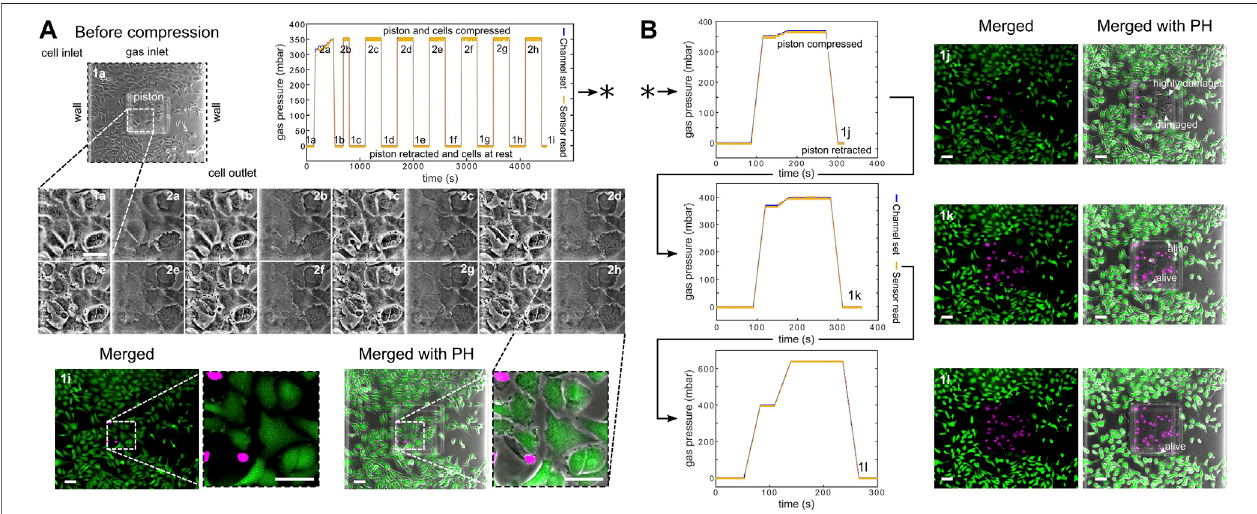
FIGURE 6 | Continuous sequence of cyclic compression pro fi les applied to a monolayer of SKOV-3 cancer cells in a continuous manner. (A) Before compression image of the cells corresponds to step “ 1a ” of the cyclic compression. In the fi rst pressure pro fi le, at step “ 2a, ” a pressure amount ladder was formed up to 354 mbar, duringwhichcellsshoweddistinctdeformation.Subsequently,cellswerechronicallycompressedfor5 minat354 mbarandthenrestedfor5 minat0 mbar(1b-i,2b-h). This cyclic compression was applied for 1 h. The close-up image sequence shows example cell shapes/deformations under the micro-piston, while cells were compressed/rested throughout the cycles, with steps “ 1a-i ” and “ 2a-h ” corresponding to cells at rest and cells compressed, respectively. Cell viability was monitored 10 – 15 minafter thepressureapplication pro fi lewascompleted(1i).Livecells(green)anddead cells(magenta) wereimagedwithcalceinAMandethidiumhomodimer-1 (EthD-1) epi- fl uorescence, respectively, and merged with phase-contrast images. (B) Continuation (*) of the pressure application, with pressure increased to 370, 400, and640 mbar,respectively.Cellswerecompressedforupto2 minateachhigherpressure.Arrowheads(inwhite)showtherepresentativecellsforviabilitystateandcell damageasaresultofgraduallyincreasingcompressionduring eachcorrespondingpressurepro fi le(allscalebars100 µm).Merged: mergedform ofthecalceinAMand EthD-1 epi- fl uorescence images; merged with PH: merged form of the epi- fl uorescence images with the corresponding phase-contrast (PH)